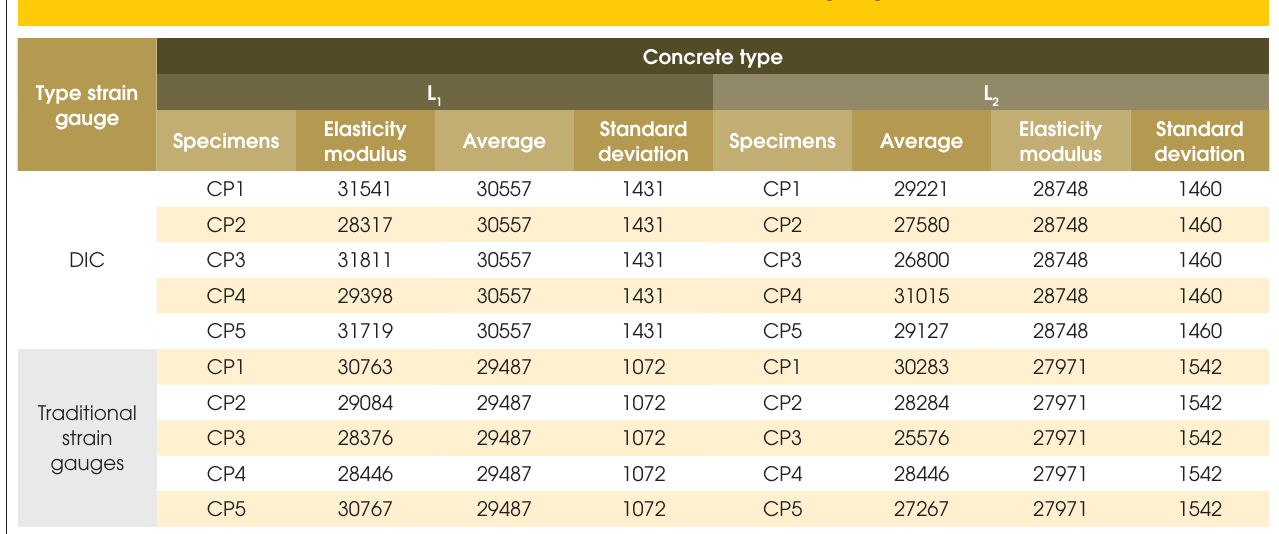
Table 2 – Comparative data between the results obtained using the DIC technique and the traditional strain gauges